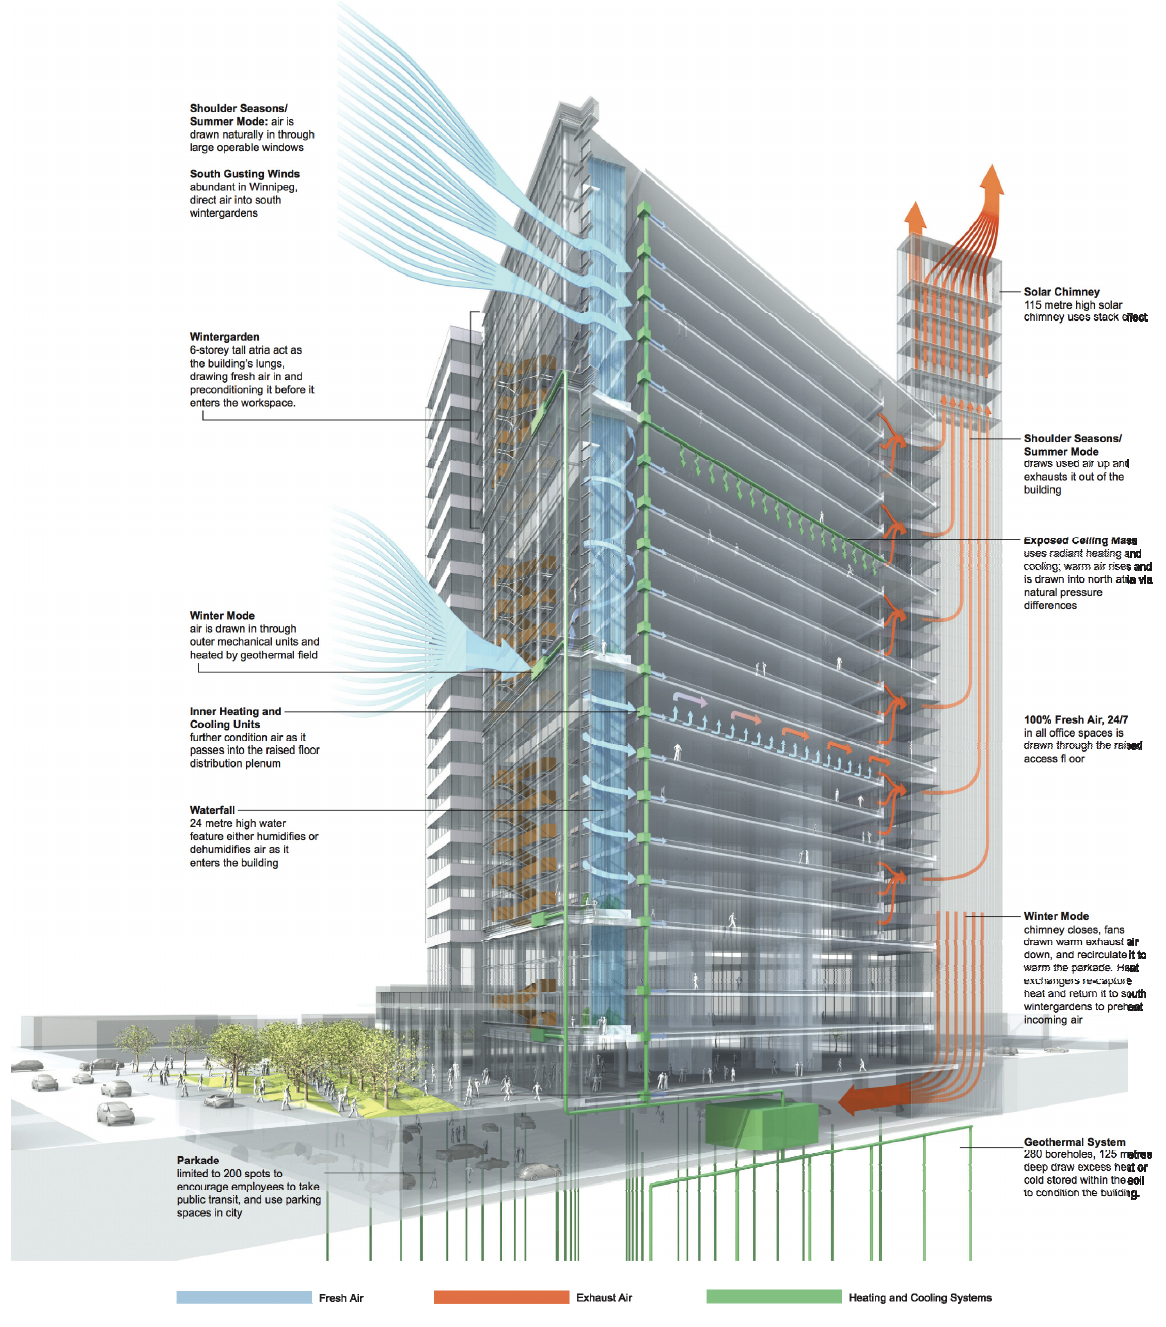
Figure 10. Manitoba Hydro by Transsolar—Systems Diagram by Brian Christie